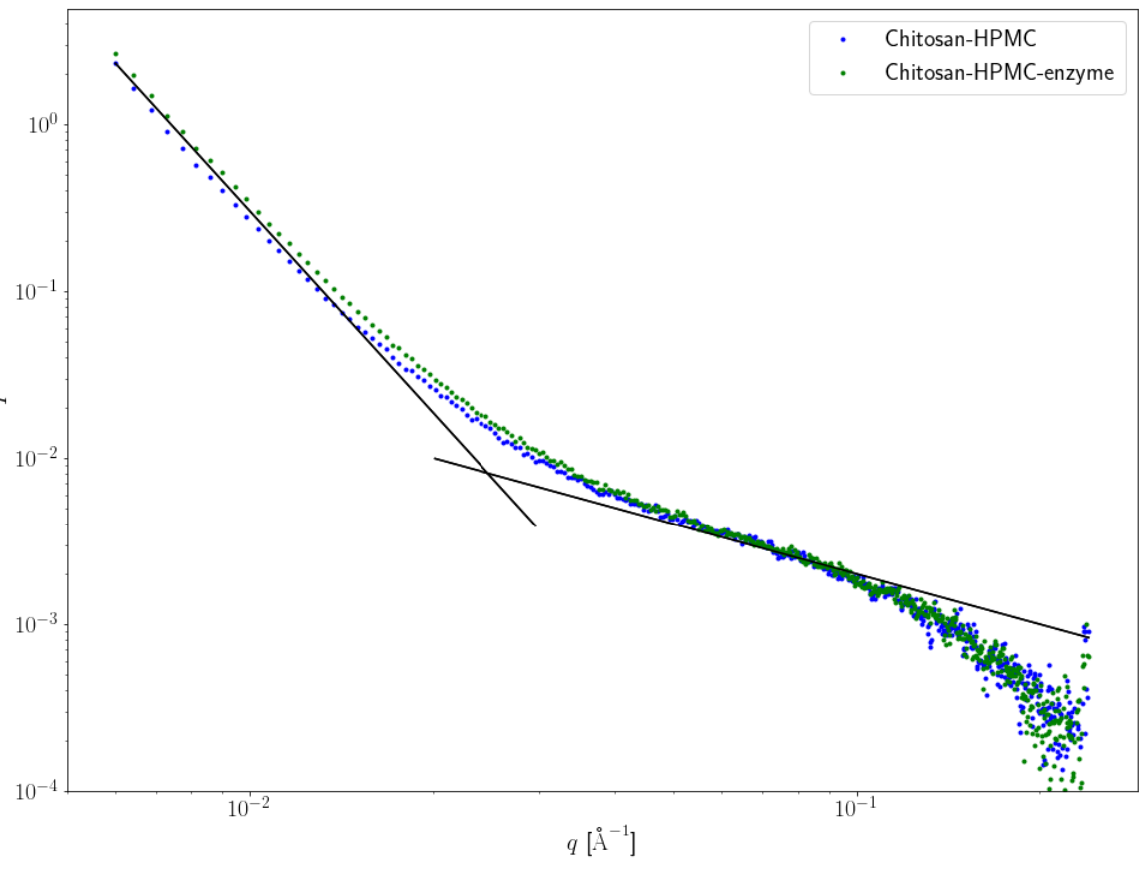
Figure 2. Processed (background-subtracted) data; double logarithmic scale; SAXS spectra for HPMC:CS films. Blue curve: empty film; green curve: enzyme-loaded film. HPMC:CS = 2:1. Enzyme: M. miehei lipase, 1 mg/g of film. The two superimposed black lines correspond to power-law decays, as 1/q⁴ and 1/q, respectively.